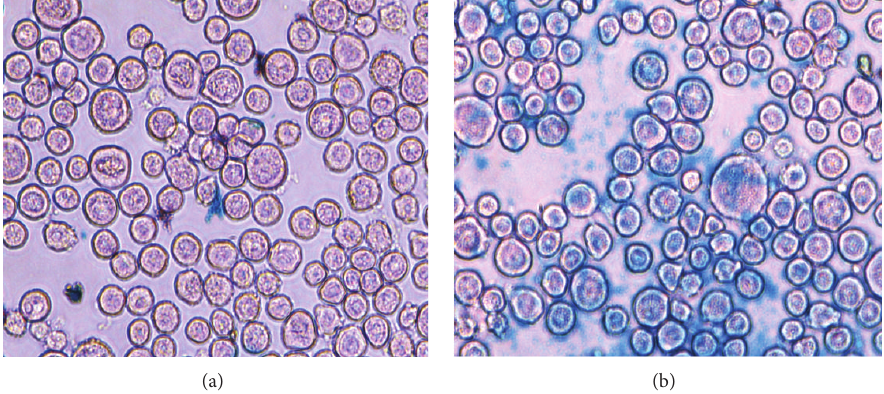
Figure 7: Prussian blue staining images (objective magnification: × 40) for OVCAR3 cells after 1h incubation with (a) Nanomag-D-SPIO and (b) SPIONs-C595 nanoprobe.